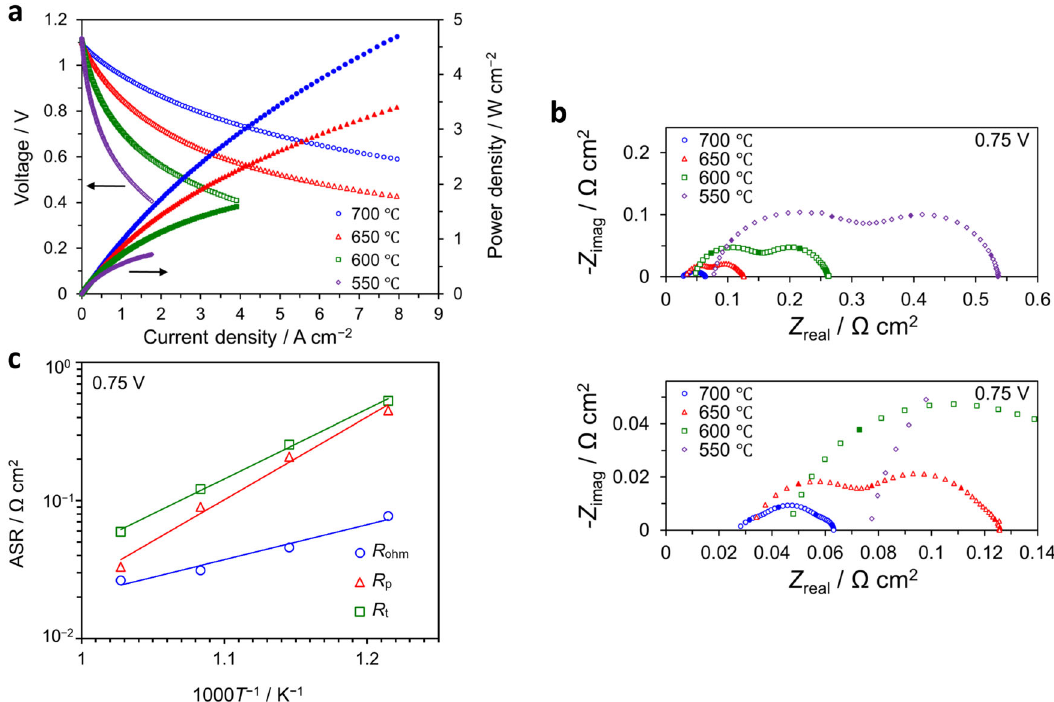
Fig. 8 Electrochemical performance of anode-supported cell. This cell, utilizing a nanoengineered cathode layer comprising nanoporous LSC and LSCF- GDC nanocomposite, was evaluated using humidi fi ed (3% H 2 O) H 2 as fuel and dry air as oxidant at various temperatures (700 °C: blue circles, 650 °C: red triangles, 600 °C: green squares, 550°C: purple diamonds). a Current – voltage ( I – V ) and current – power ( I – P ) curves evaluated at various temperatures. b Impedance spectra for the anode-supported cell at an operating condition of 0.75 V. c ASRs for the anode-supported cell as determined from impedance spectra ( R p : polarization resistance, R ohm : ohmic resistance, R t = total resistance). Table 1 Electrochemical performance of selected anode-supported cells. Component